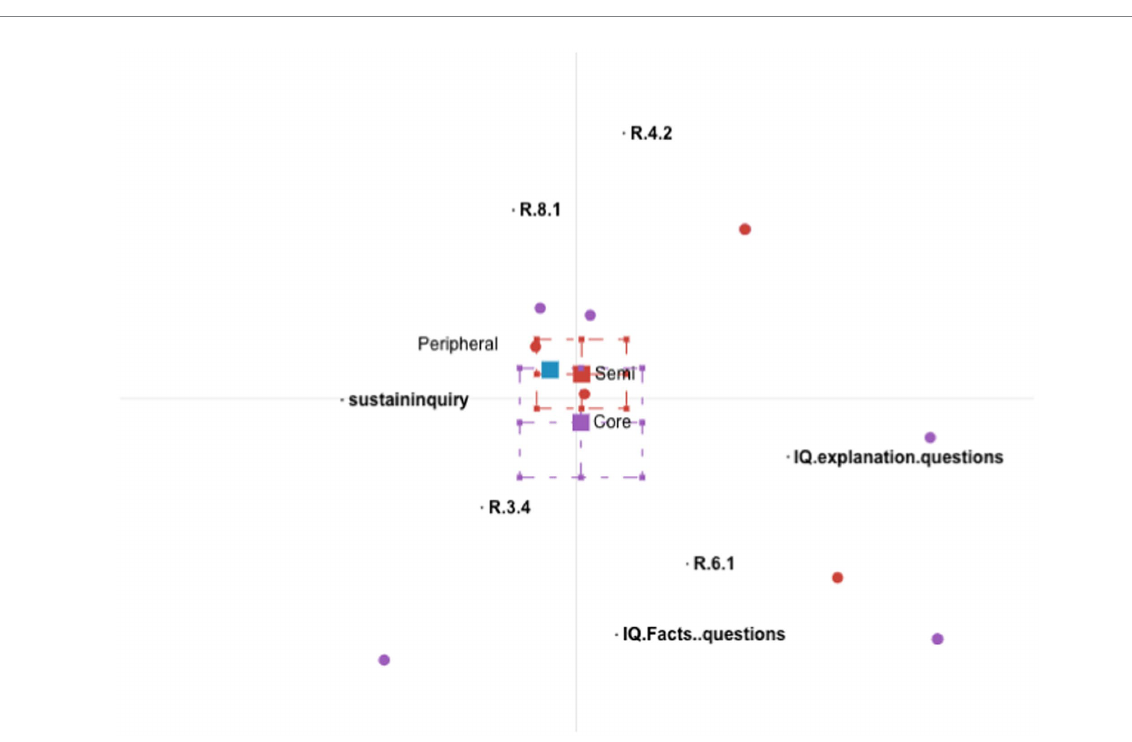
FIGURE 5 Epistemic network analysis participation graph for peripheral group. Core = leader; semi =